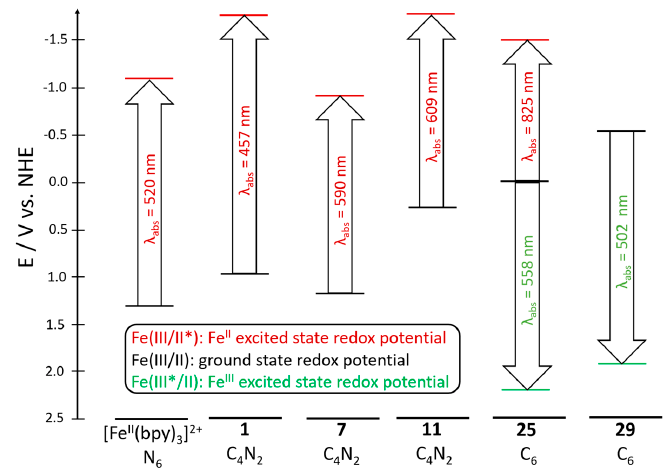
Figure 8. Photo(electro)chemical properties of selected FeNHC complexes ( 1 , 7 , 11 , 25 , and 29 ) discussed in the text, correlating estimated excited state redox potentials with the Fe(III/II) ground state redox levels as well as measured Fe(II) or Fe(III) excitation energies. Note that simple estimates of the excited state redox potentials are given from the lowest absorption features for the complexes. These values are used mainly for systematic comparative purposes, but neglect losses due to excited state relaxation (generally unknown for the non-emissive complexes).